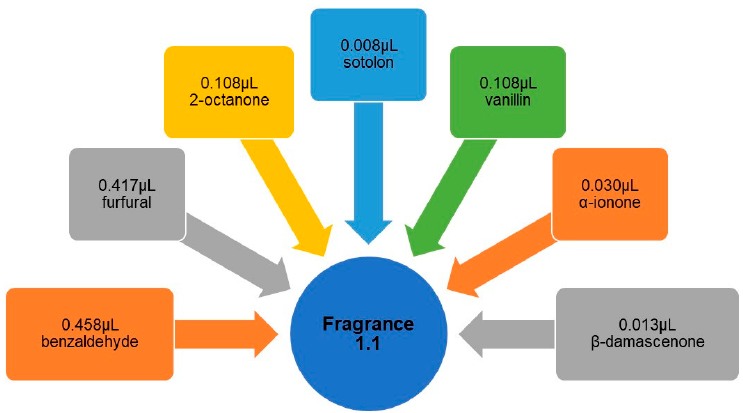
Figure 3. Aromatic compounds and respective quantities added to the fragrance 1.1.